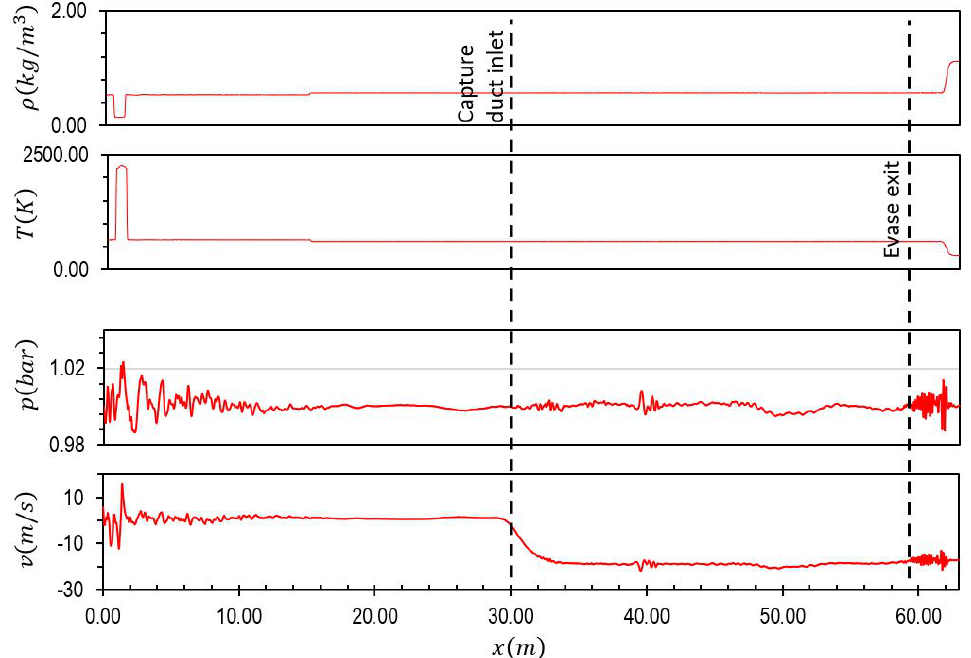
Figure 3. Profiles of gas density, temperature, pressure, and axial velocity at t = 50 ms with 7.5% methane vented from mine.